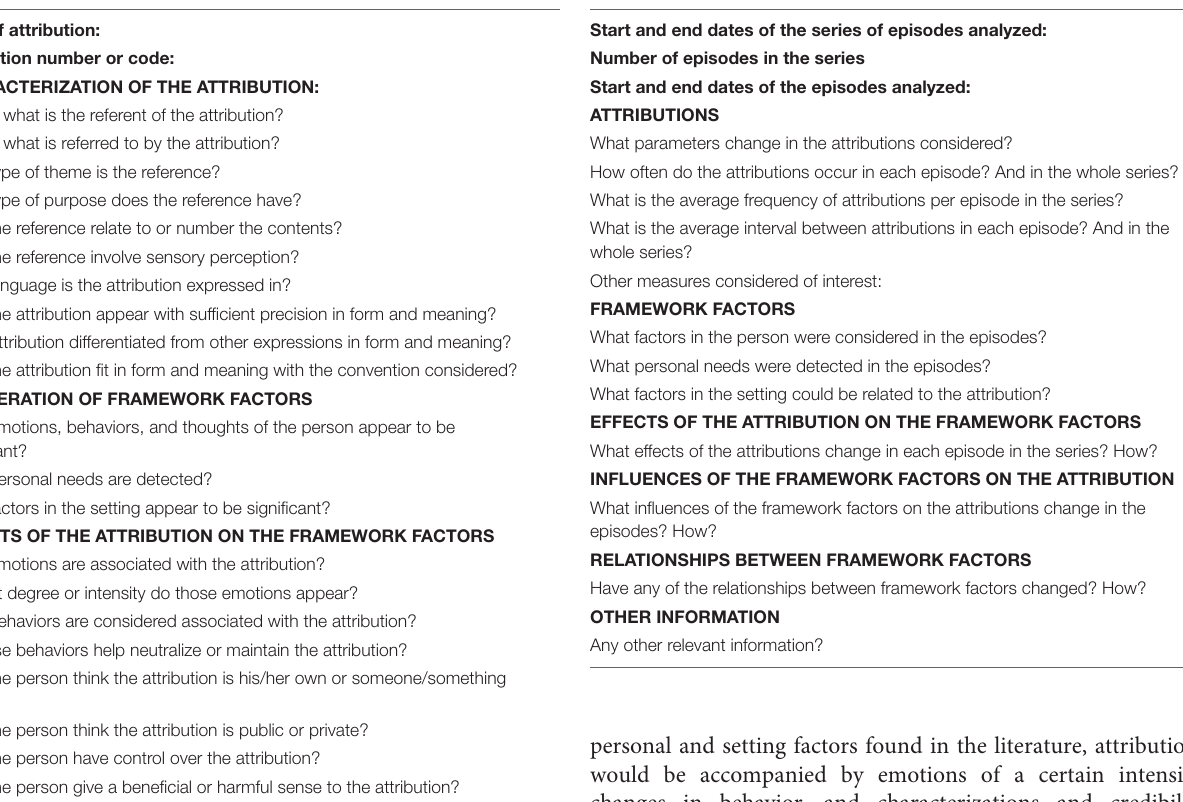
TABLE 6 | Checklist for a diachronic perspective of the attributional field. Person studied: Start and end dates of the series of episodes analyzed: Number of episodes in the